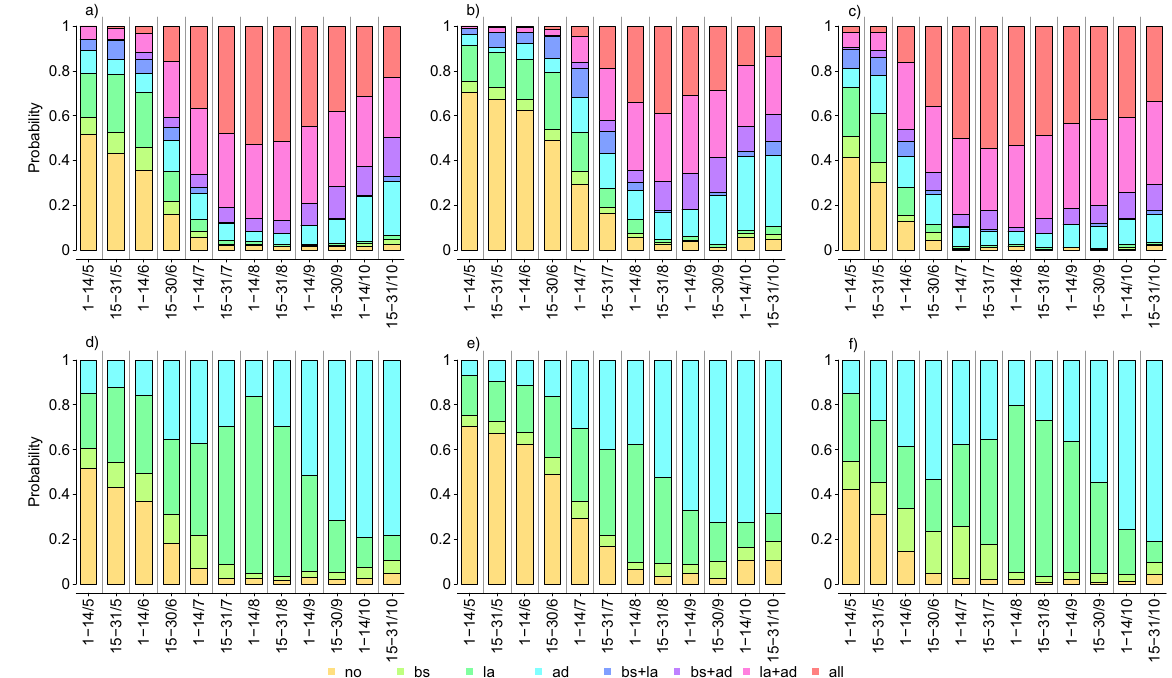
Figure 3. Top panels show probabilities of being the most cost effective of all possible strategies for different times at first notifications when considering temperature records observed during the Italian outbreak in 2007 ( a ), with temperatures decreased ( b ) or increased ( c ) by 1.5 °C. Bottom panels show probabilities of being the most cost effective among the considered single strategies for different times at first notifications with the observed temperature records ( d ), with temperatures decreased ( e ) or increased ( f ) by 1.5